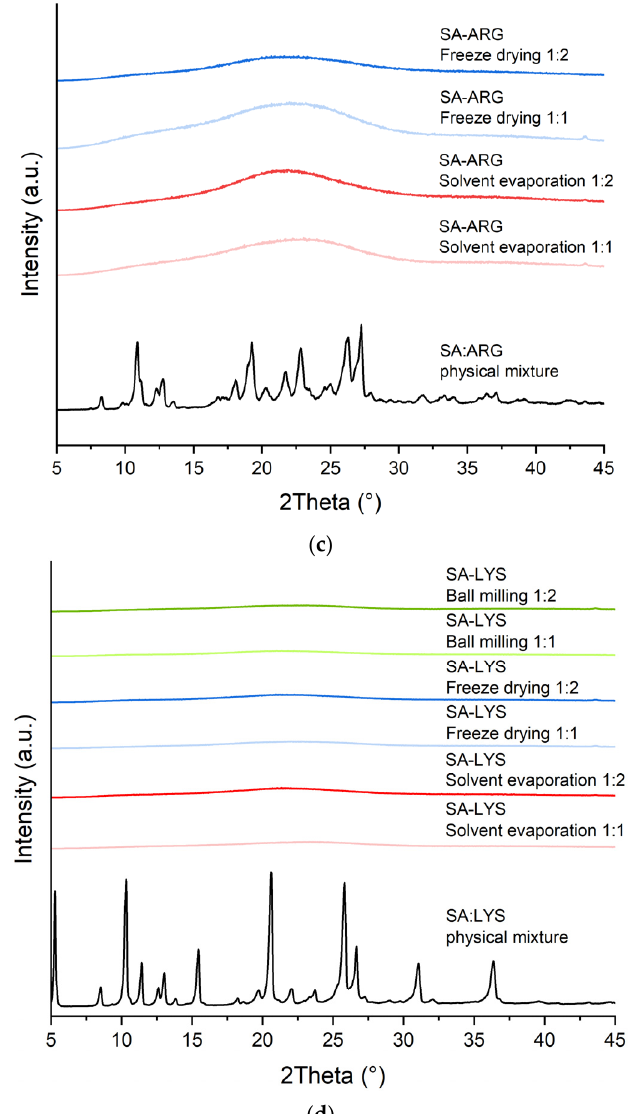
Figure 1. The XRPD diffraction patterns of SA ( a ), co-amorphous systems of SA with TRP and the physical mixture ( b ), co-amorphous systems of SA with ARG and the physical mixture ( c ), co-amorphous systems of SA with LYS and the physical mixture ( d ).